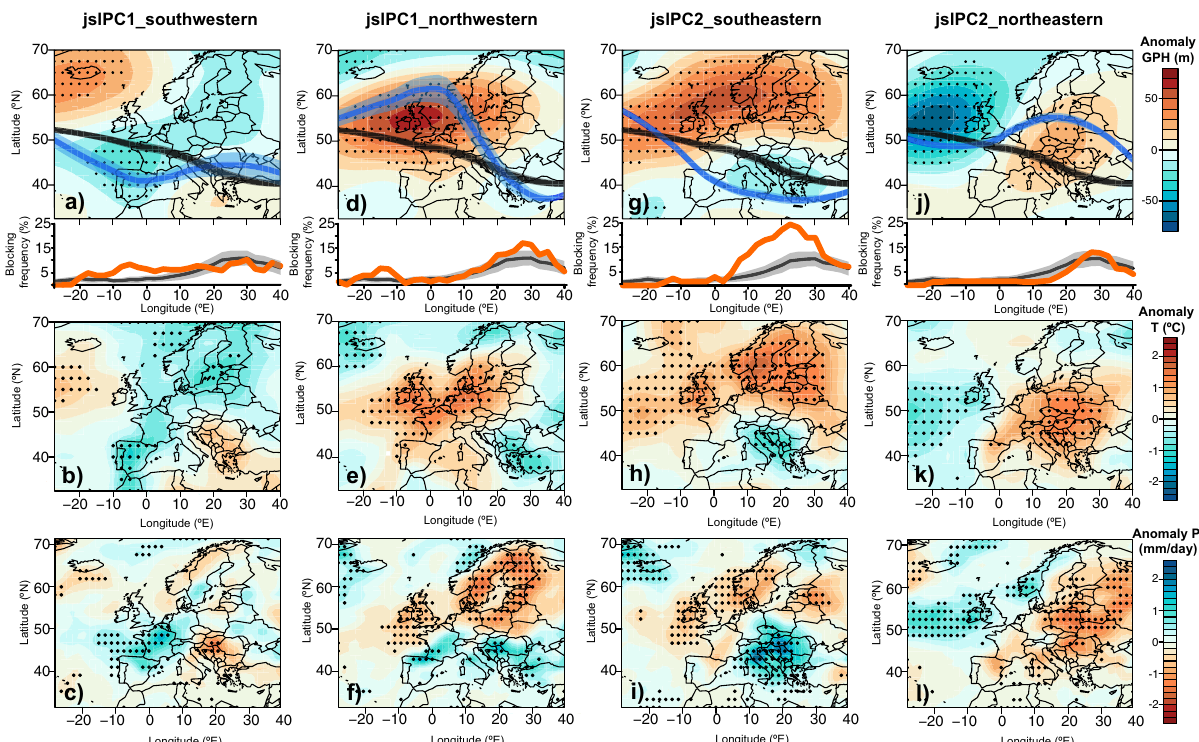
Fig. 1 July – August composite climate anomalies during jet stream latitude (JSL) extreme years (i.e., D90 and D10 of jslPC1 and jslPC2 scores). Maps represent averaged July – August anomalies during southwestern, northwestern, southeastern, and northeastern JSL extremes of 500 mbar geopotential height (GPH; m) ( a , d , g , j ), air temperature (T; °C) ( b , e , h , k ), and precipitation (P; mm/day) ( c , f , i , l ). Black dots represent signi fi cant ( p < 0.05) departures from the long-term mean climatology. Line graphs in the top panels also show the mean July – August JSL position for the fi ve extreme years (blue line) and standard error (blue shading) compared to the mean for the period 1950 – 2005 (black lines and shading). Orange lines represent the mean July – August blocking frequency per longitudinal section for the fi ve extreme years compared to the mean for the period 1950 – 2005 (gray line). Gray- shaded areas around blocking frequency climatological mean correspond to two standard deviations from the